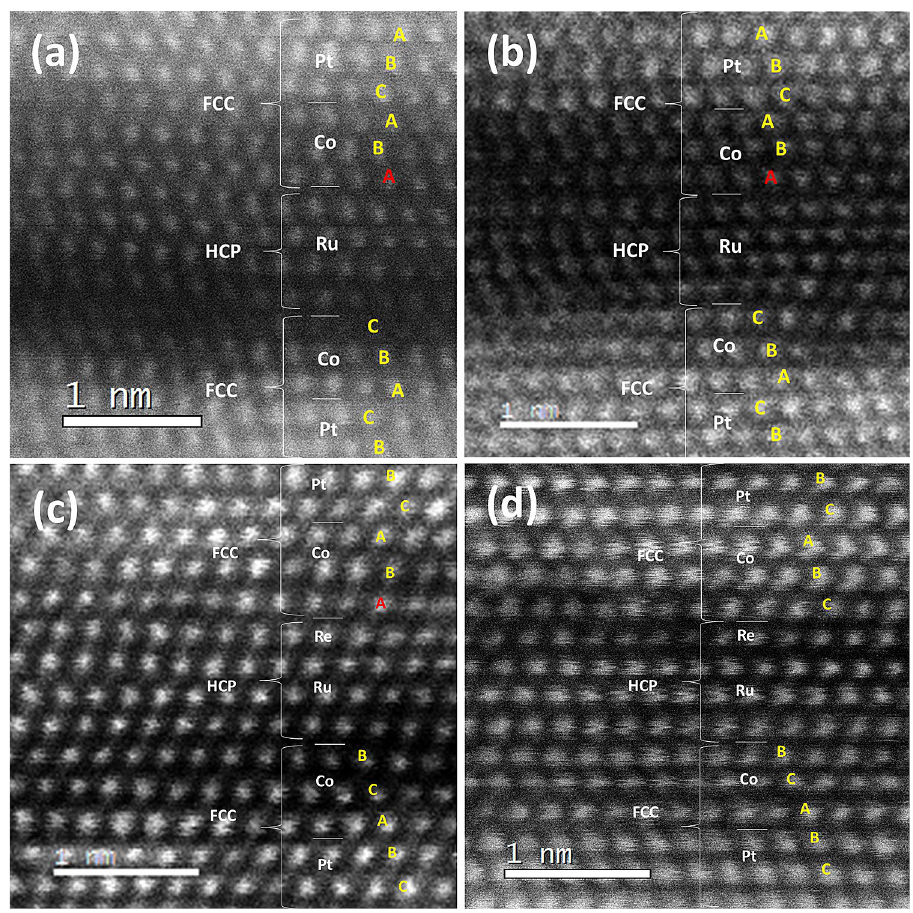
Figure 6. STEM-HAADF image of SAFs. ( a ) and ( b ) SAF with a single Ru spacer in the as-deposited and annealed state, respectively. ( c ) and ( d ) SAF with a Ru/Re composite spacer at as-deposited and annealed state, respectively. The elements and crystal structures are indicated. The types of atom positions are noted by A, B and C in yellow and the stacking fault layer is marked in